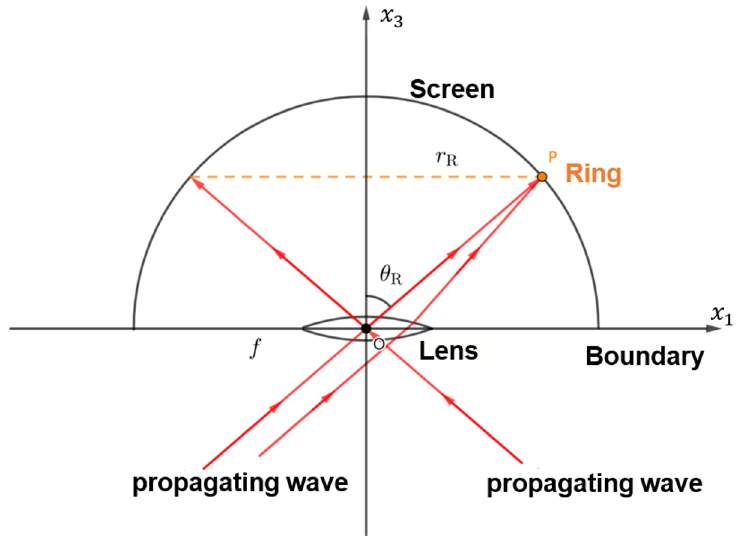
Figure 3 . The relation between θ R and r R